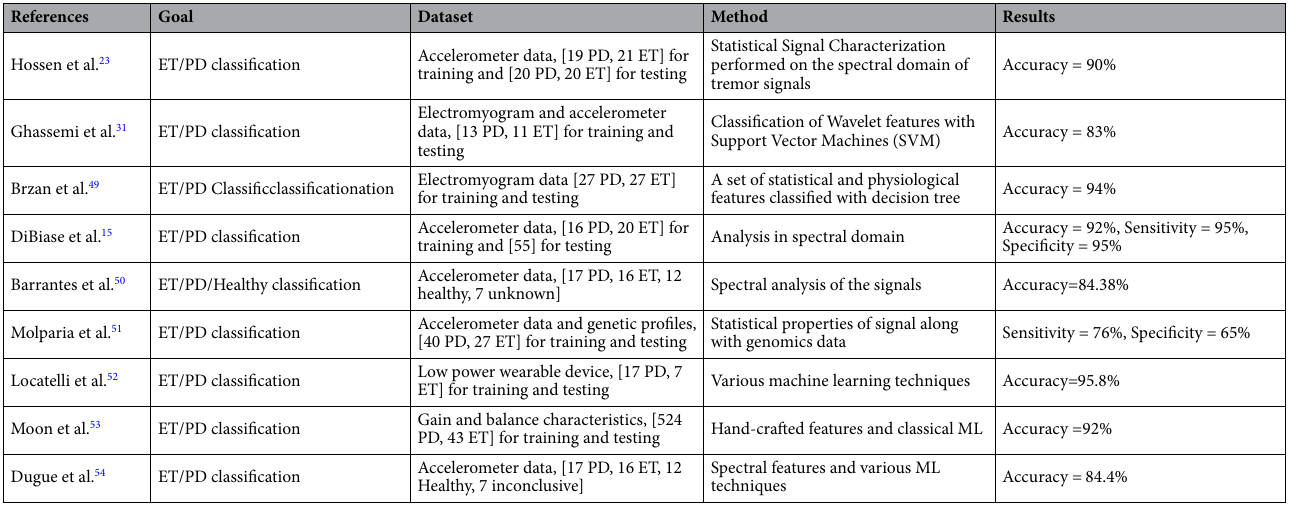
Table 1. Literature review of the recent works in ET/PD